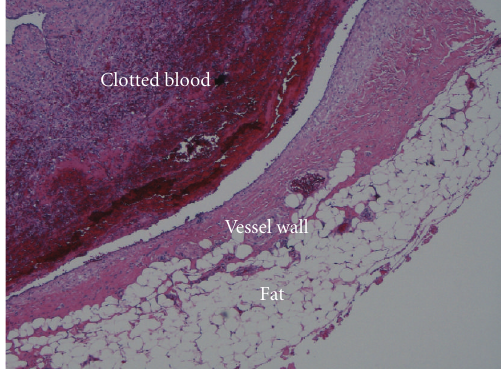
Figure 4: Microscopic view of the aneurysm with an organized blood clot in the lumen and a focally thinned muscular